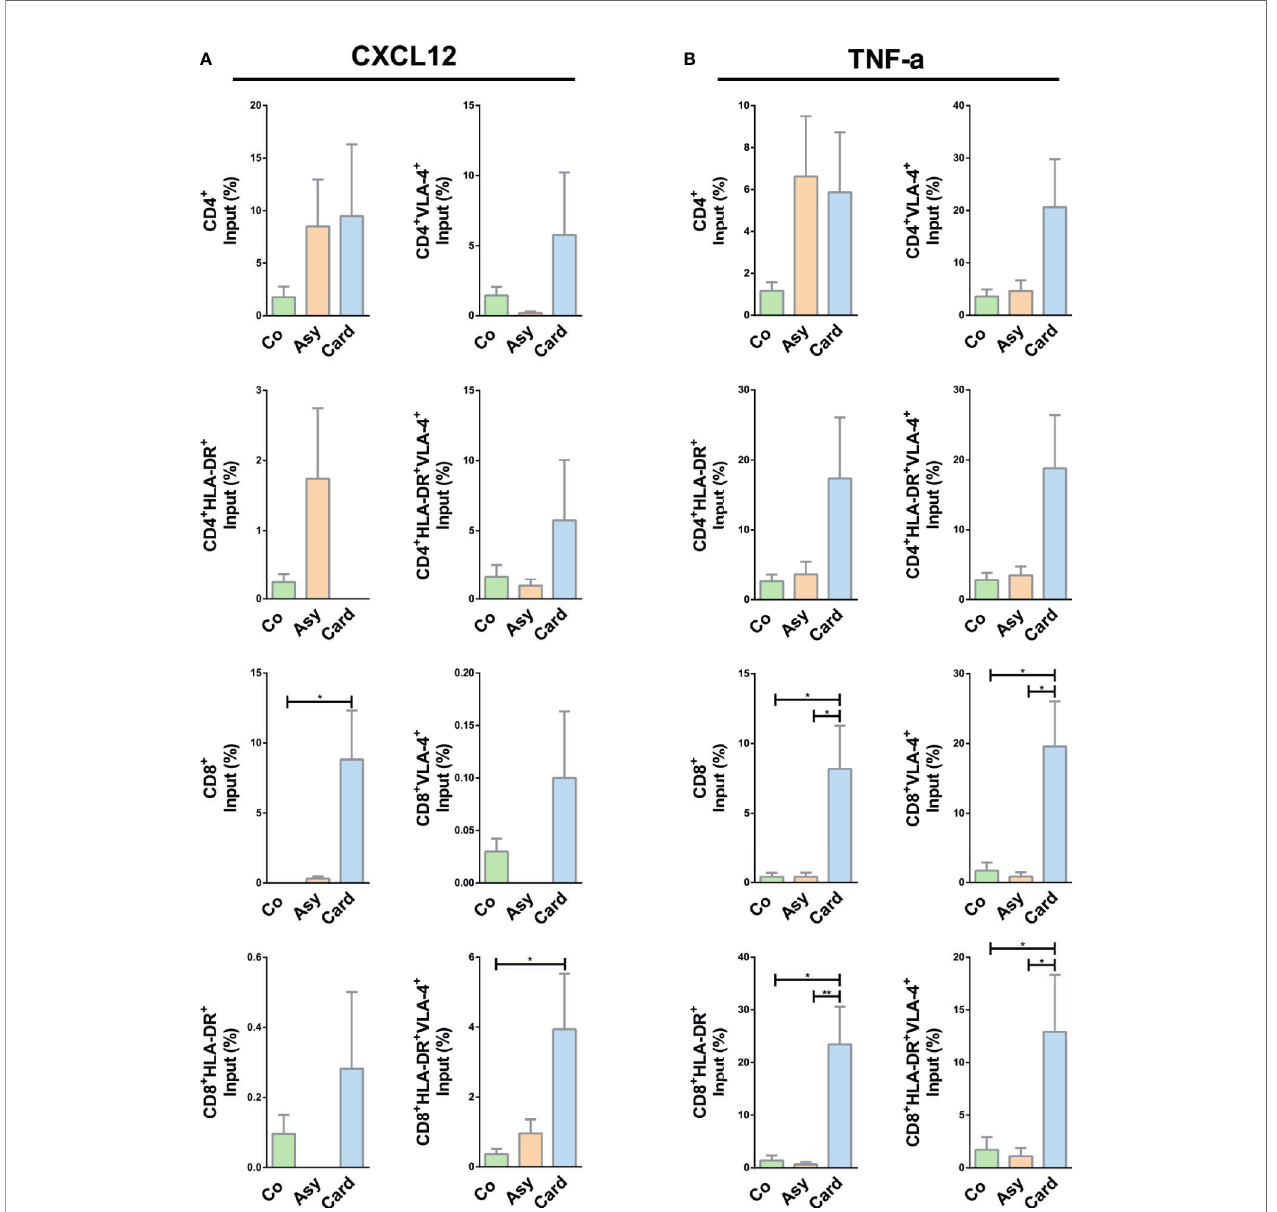
FIGURE 5 | CXCL12- or TNF- a -driven migratory response of T cells from chagasic patients. (A) Percentage of input of different T cell subpopulations expressing VLA-4 and HLA-DR in FN+CXCL12 coated transwells. (B) Percentages of input for different T-cell subpopulations expressing VLA-4 and HLA-DR in FN+ TNF- a coated transwells. *p < 0.05 and **p < 0.01 versus Controls. Kruskal-Wallis followed by Mann-Whitney U test were used for statistical analyses. Co, Control (n = 20); Asy, Asymptomatic (n = 20); Card: Cardiac (n =